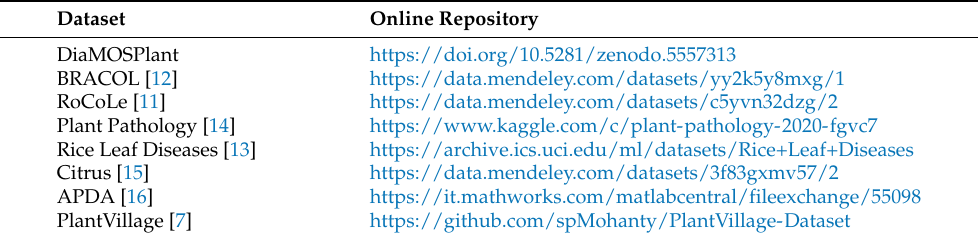
Figure 2. Graphical size distribution of the examined datasets. Table 7. Public image datasets with the related on-line